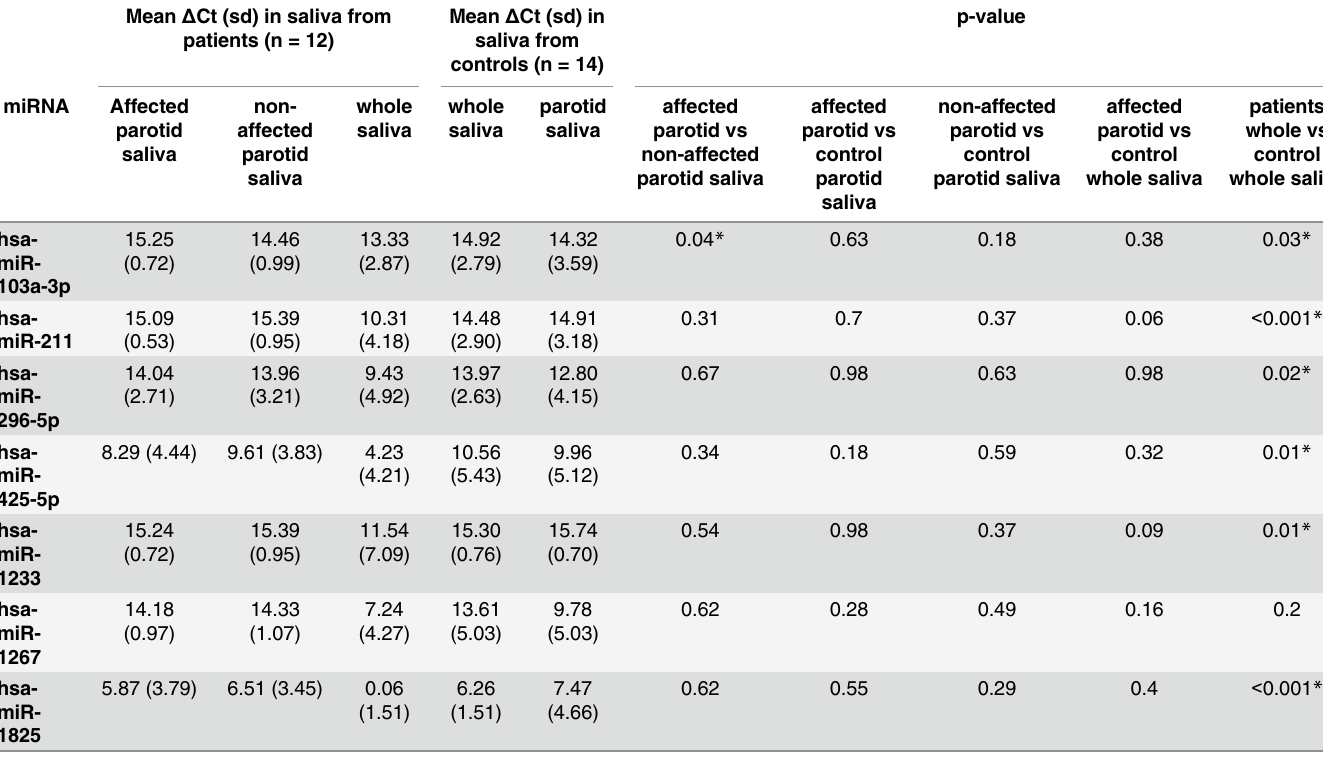
Table 4. Mean Δ Ct (sd) of validated salivary miRNA biomarkers in whole saliva and parotid saliva from patients and controls. Mean Δ Ct (sd) in saliva from Mean Δ Ct (sd) in patients (n = 12) saliva from controls (n = 14)